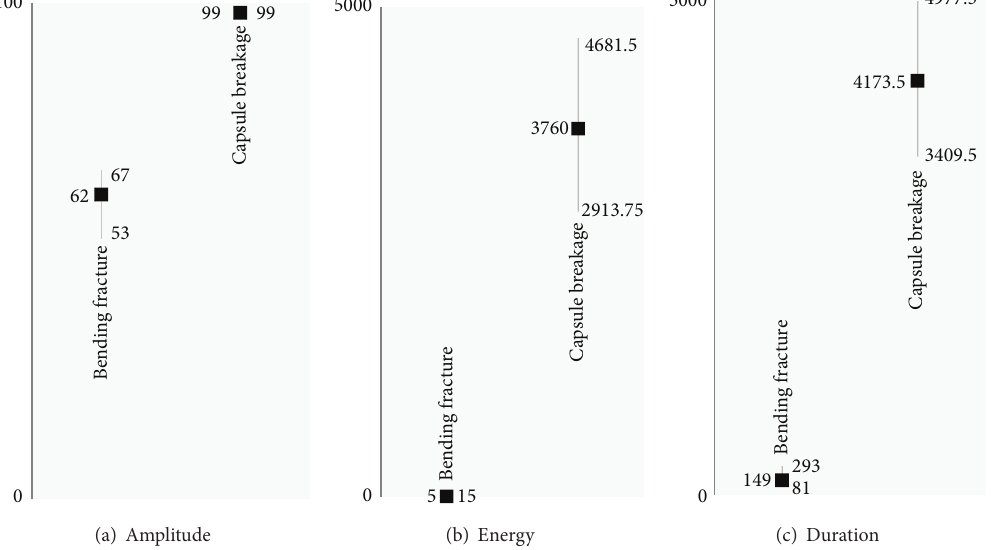
Figure 16: Clustering of AE features-part 1.